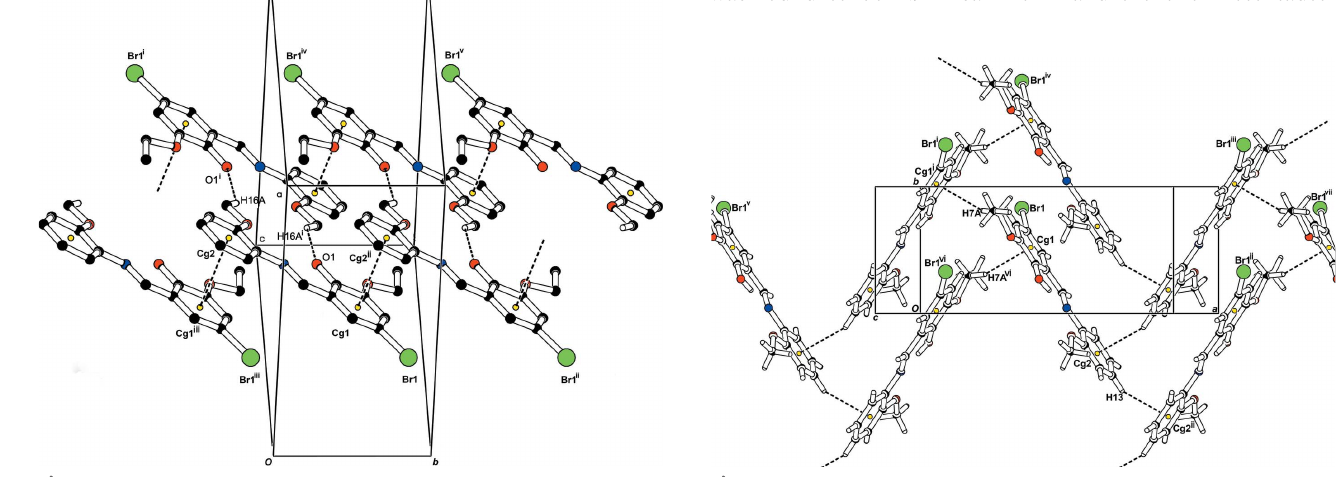
Figure 3 The packing, viewed down the c axis, showing molecules connected by